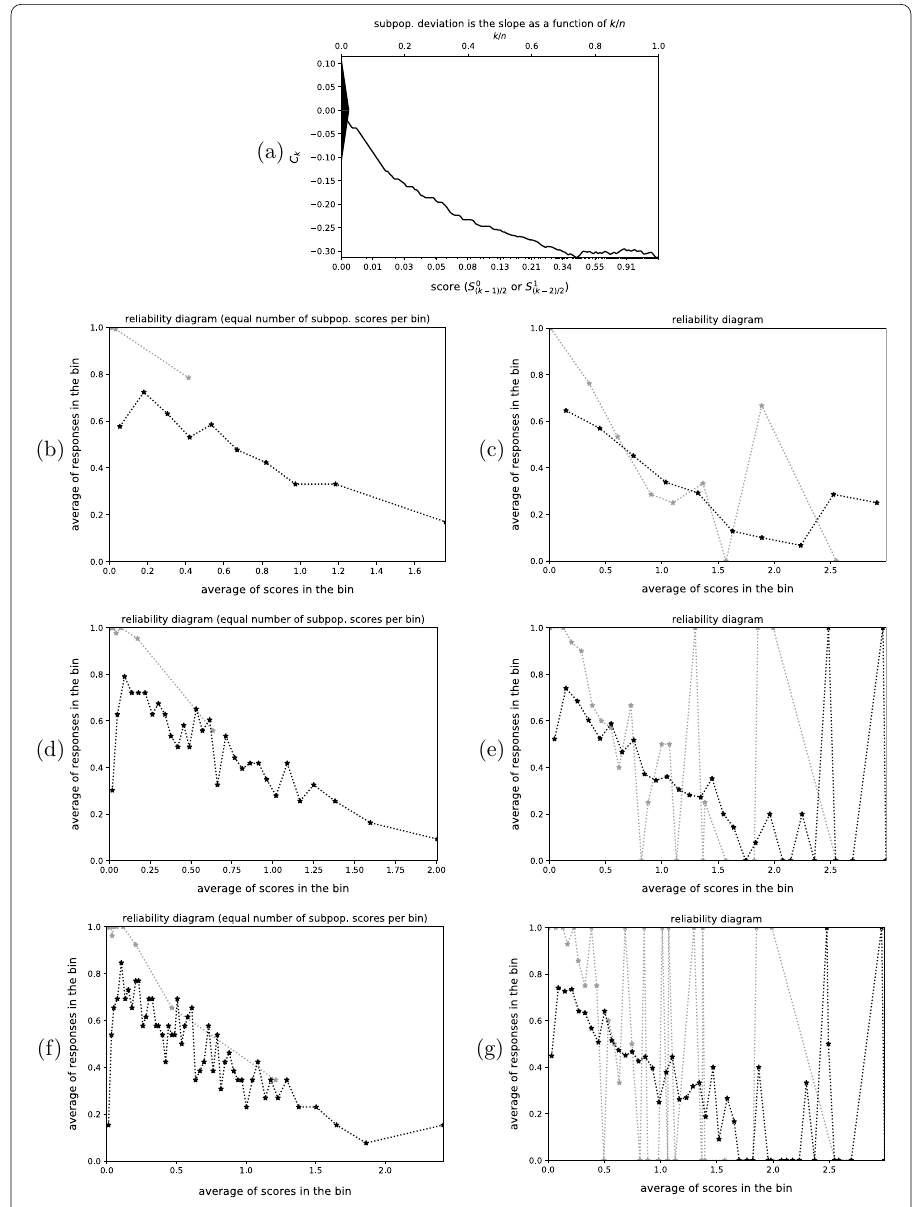
Fig. 8 Night snake (Hypsiglena torquata) vs. Monarch (or milkweed) butterfly (Danaus plexippus); n = 304; Kuiper’s statistic is 0.3138 /σ = 5.471 , Kolmogorov’s and Smirnov’s is 0.3138 /σ = 5.471 ; the lack of deviation at large scores is hard to detect without 30 bins or more ( d , e , f , and g ), but then the reliability diagrams are too noisy for other scores. Moreover, the diagrams with only 10 or 30 bins ( b , c , d , and e ) smooth away the extreme deviation for the lowest scores. The graph of cumulative differences ( a ) captures all phenomena nicely simultaneously. The statistics of Kuiper and of Kolmogorov and Smirnov both report very highly statistically significant deviations between the